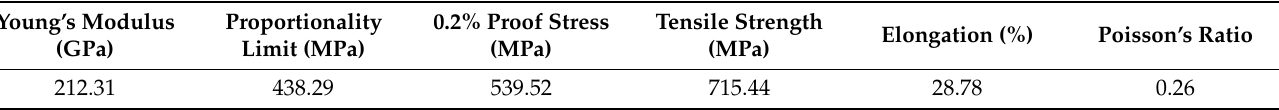
Table 1. Mechanical properties of SUS410 steel in this work.